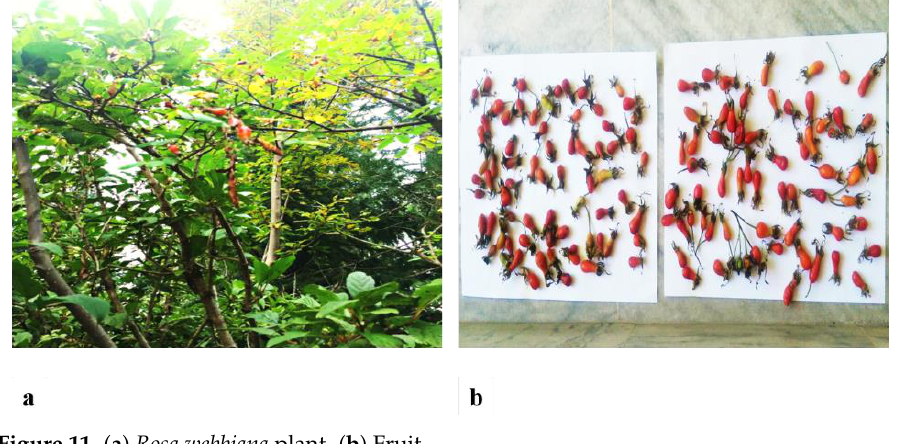
Figure 11. ( a ) Rosa webbiana plant. ( b ) Fruit.